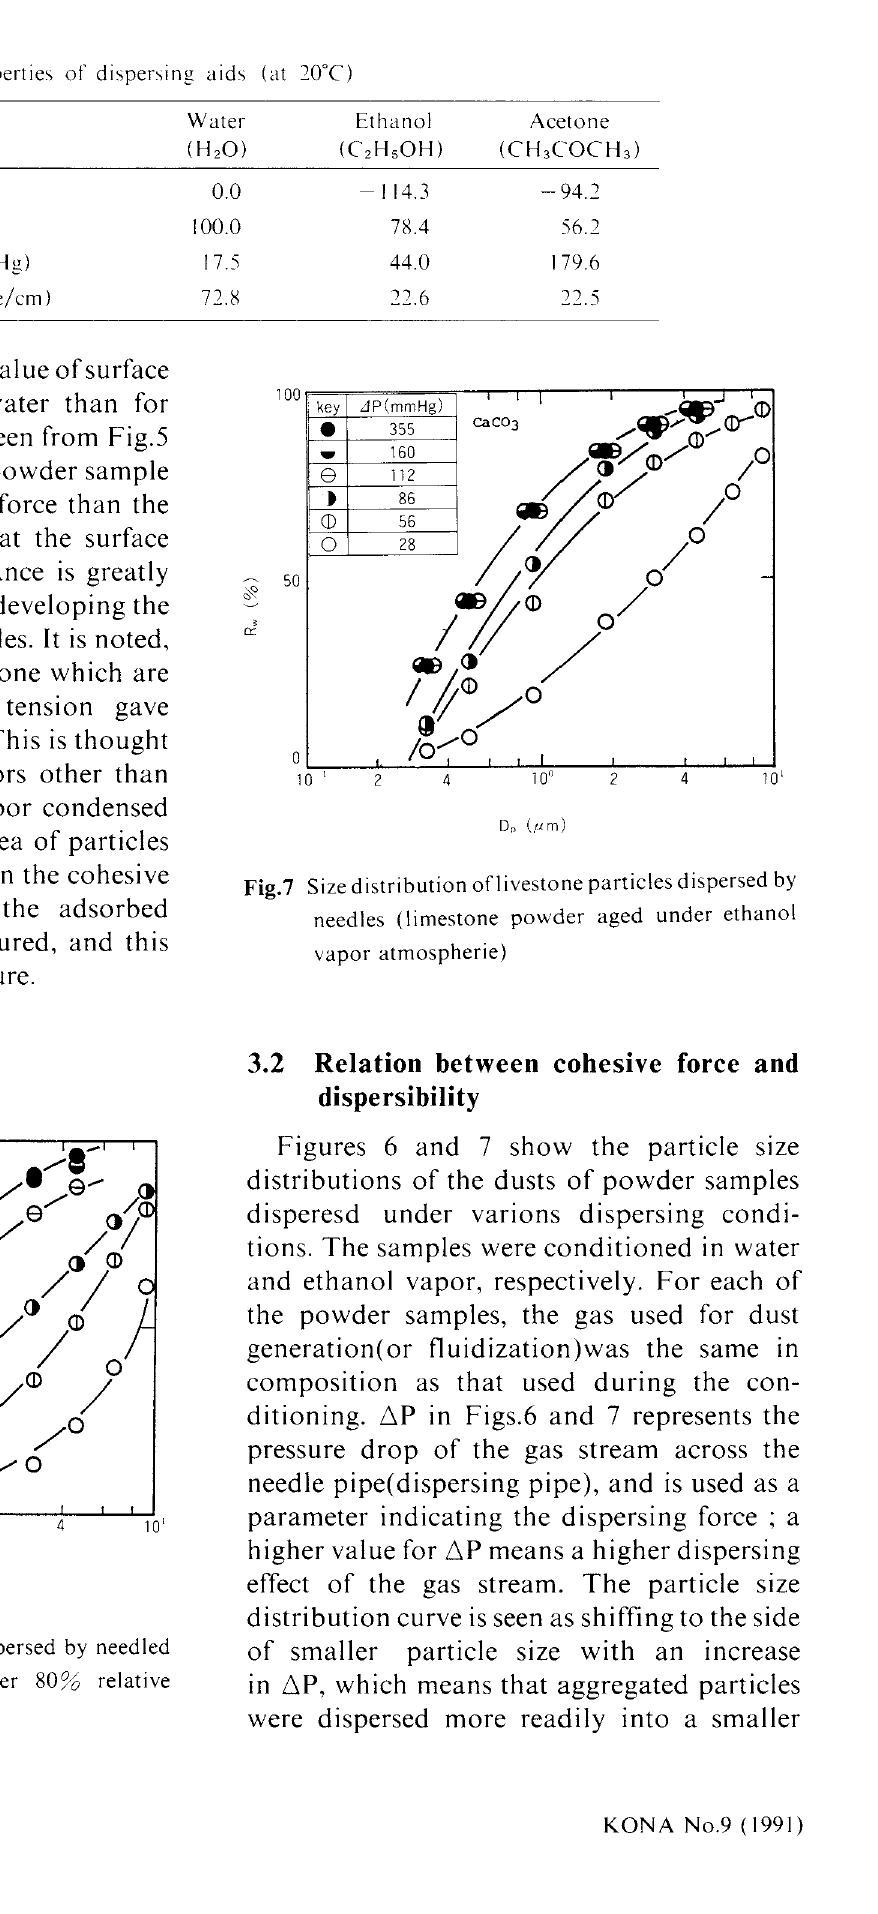
Fig.6 Size disribution of particles dispersed by needled (limestone powder aged under 80% relative humidity)